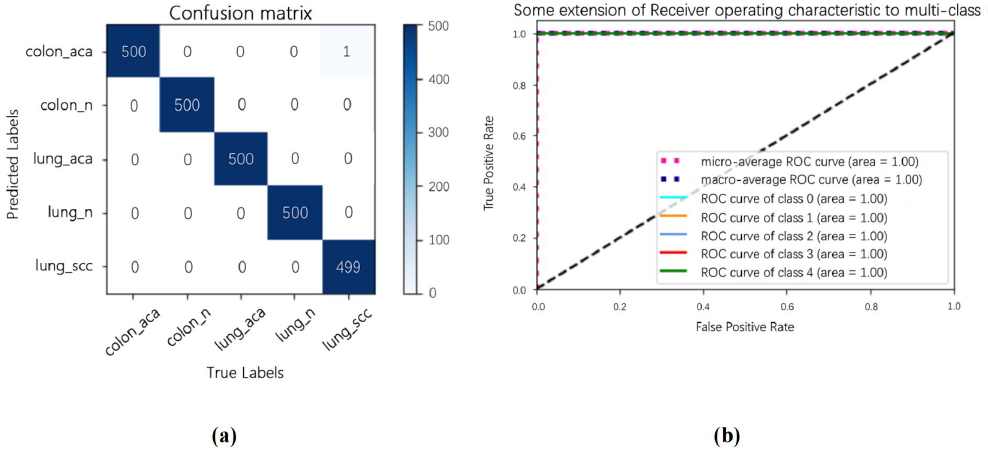
Figure 8. SENet50 _CroReLU classification results on LC25000 data showing ( a ) confusion matrix and ( b ) ROC